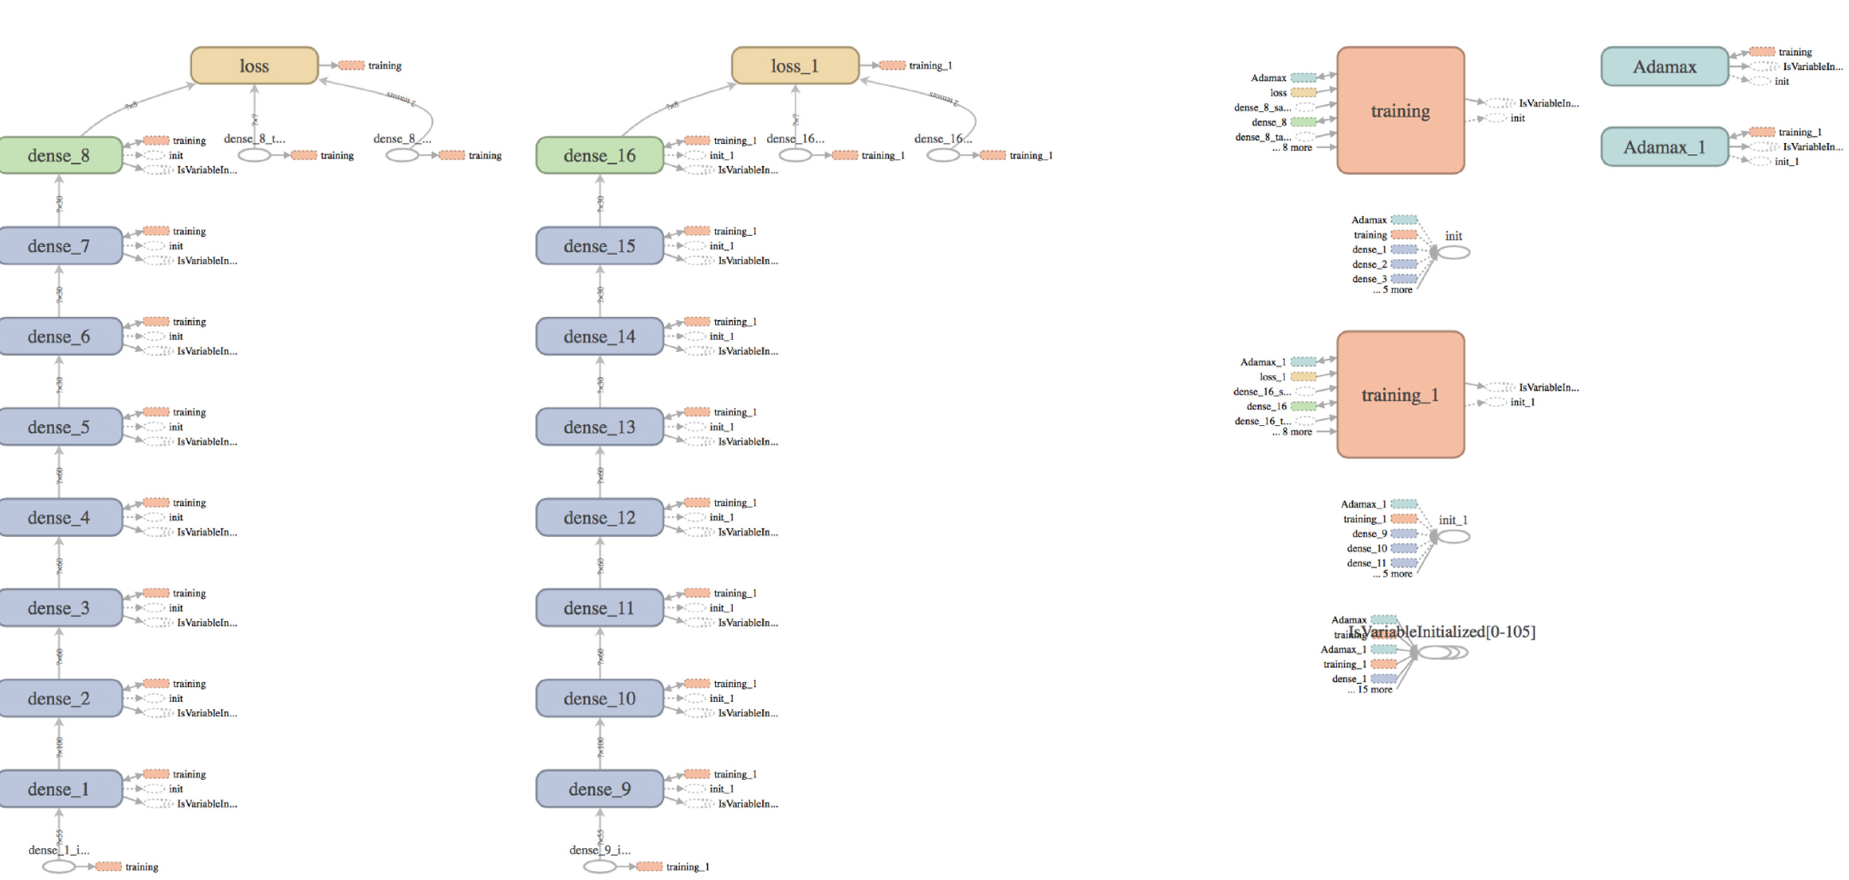
Figure A1. Architecture of the deep neural network PM 2.5 forecaster.